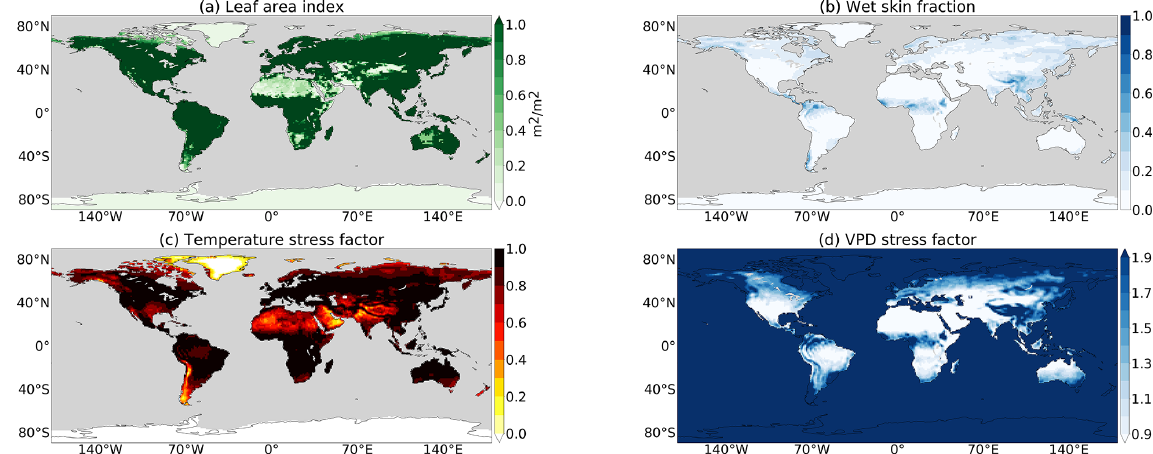
Figure B4. Boreal summer mean vegetation and meteorological variables predicted by